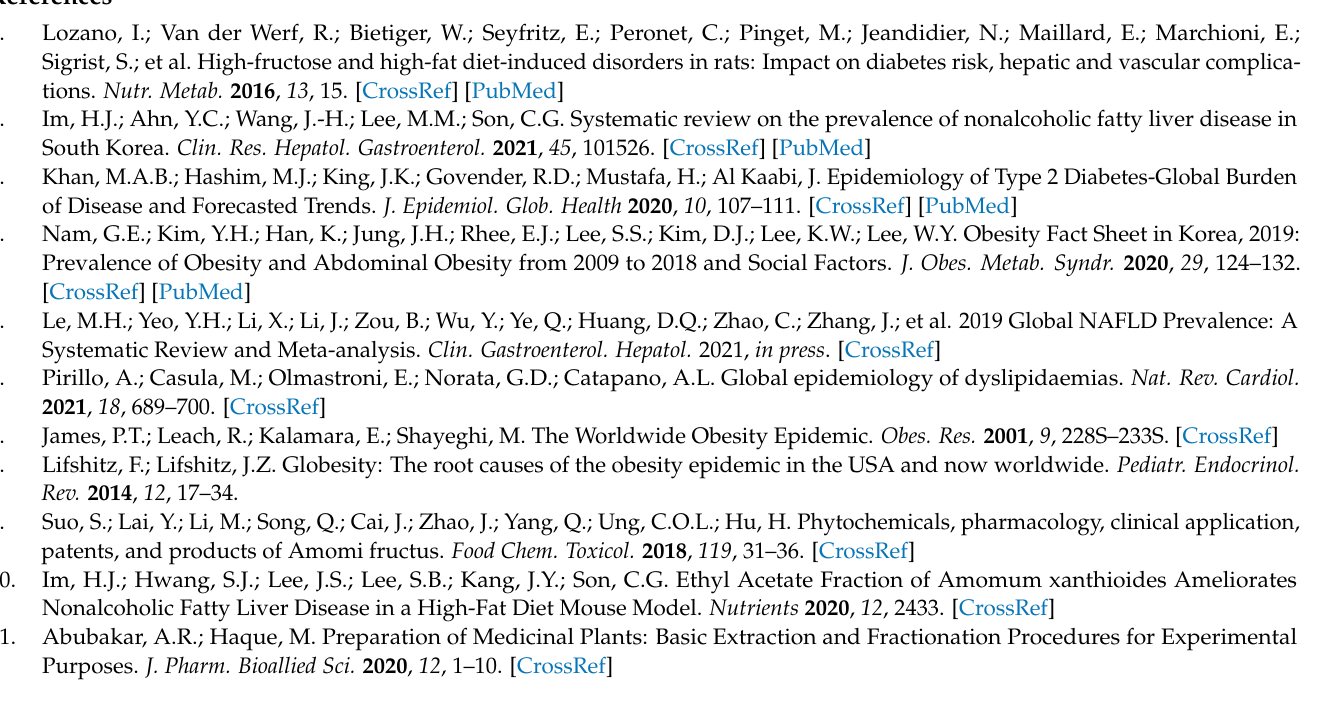
Table S2: Western blot antibody information; Figure S1: Data of the rarefaction curve; Figure S2: Correlation between gut microbiota and oxidative-stress-related